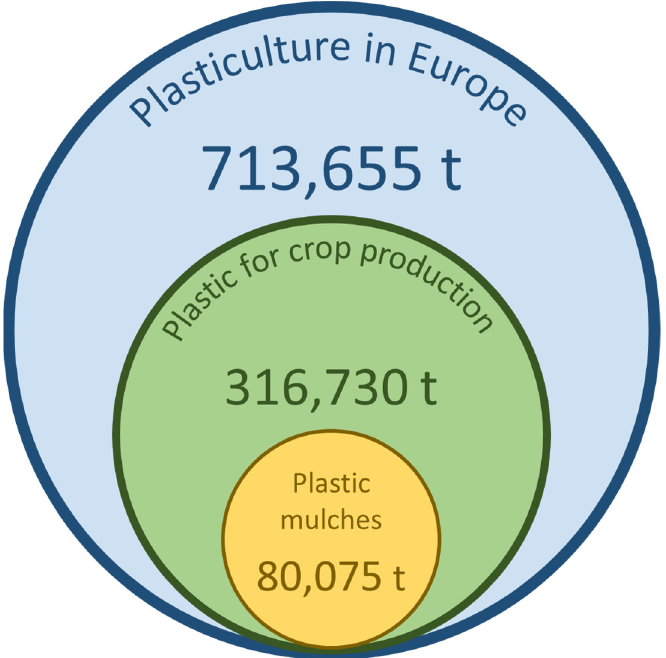
Figure 3. Venn diagram about plasticulture in Europe over the 2-year period 2018–2019. Data are expressed as tons of plastic sold. Source: APE Europe [20].